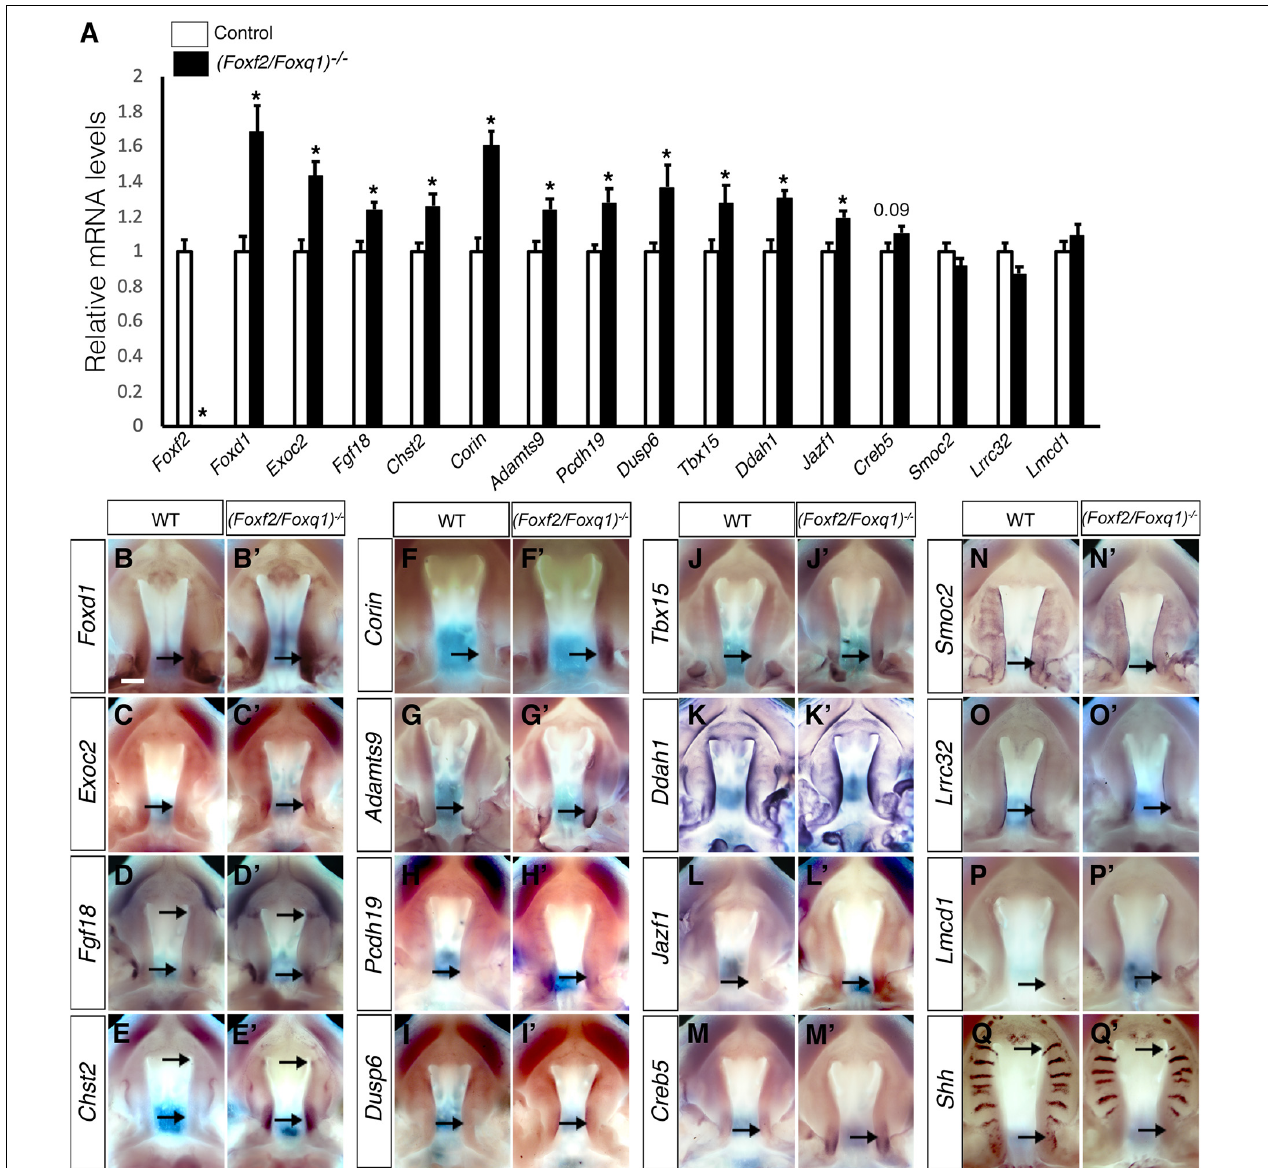
FIGURE 5 | Analysis of expression of Foxf2 target genes in the developing palatal shelves. (A) Real time RT-qPCR analysis of the levels of expression of Foxf2 , Foxd1 , Exoc2 , Fgf18 , Chst2 , Corin , Adamts9 , Pcdh19 , Dusp6 , Tbx15 , Ddah1 , Jazf1 , Creb5 , Smoc2 , Lrrc32 , and Lmcd1 mRNAs in the E13.5 palatal shelves in control and (Foxf2/Foxq1) − / − embryos ( n = 7). * p < 0.05. (B–Q, B (cid:48) –Q (cid:48) ) Comparison of patterns of expression of Foxd1 , Exoc2, Fgf18, Chst2, Corin, Adamts9, Pcdh19, Dusp6, Tbx15, Ddah1, Jazf1, Creb5, Smoc2, Lrrc32, Lmcd1, and Shh mRNAs in E13.5 wild-type (WT) (B–Q) and (Foxf2/Foxq1) − / − (B (cid:48) –Q (cid:48) ) mutant embryos. Scale bar, 400 µ